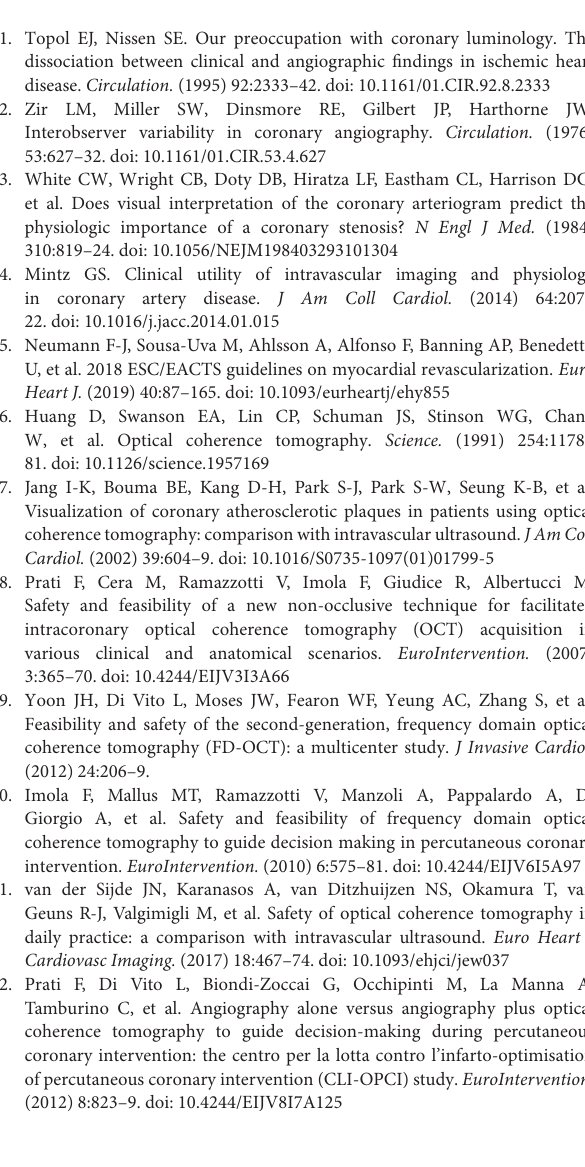
frames corresponds to the location of a marker moving in the left anterior descending (LAD)